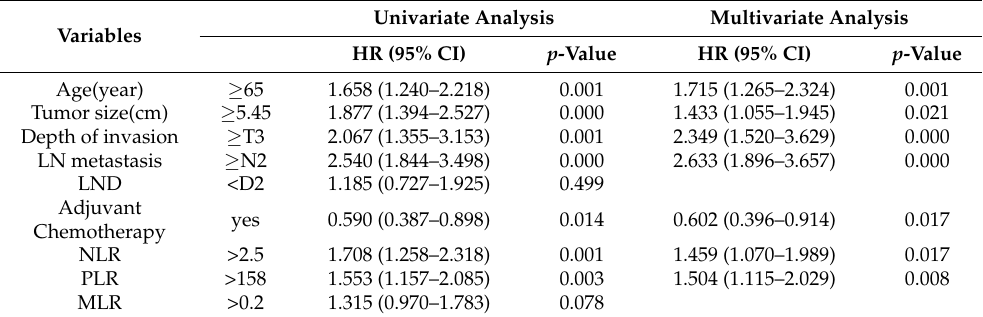
Table 3. Univariate and multivariate analysis for overall survival (OS) using Cox proportional hazard model.